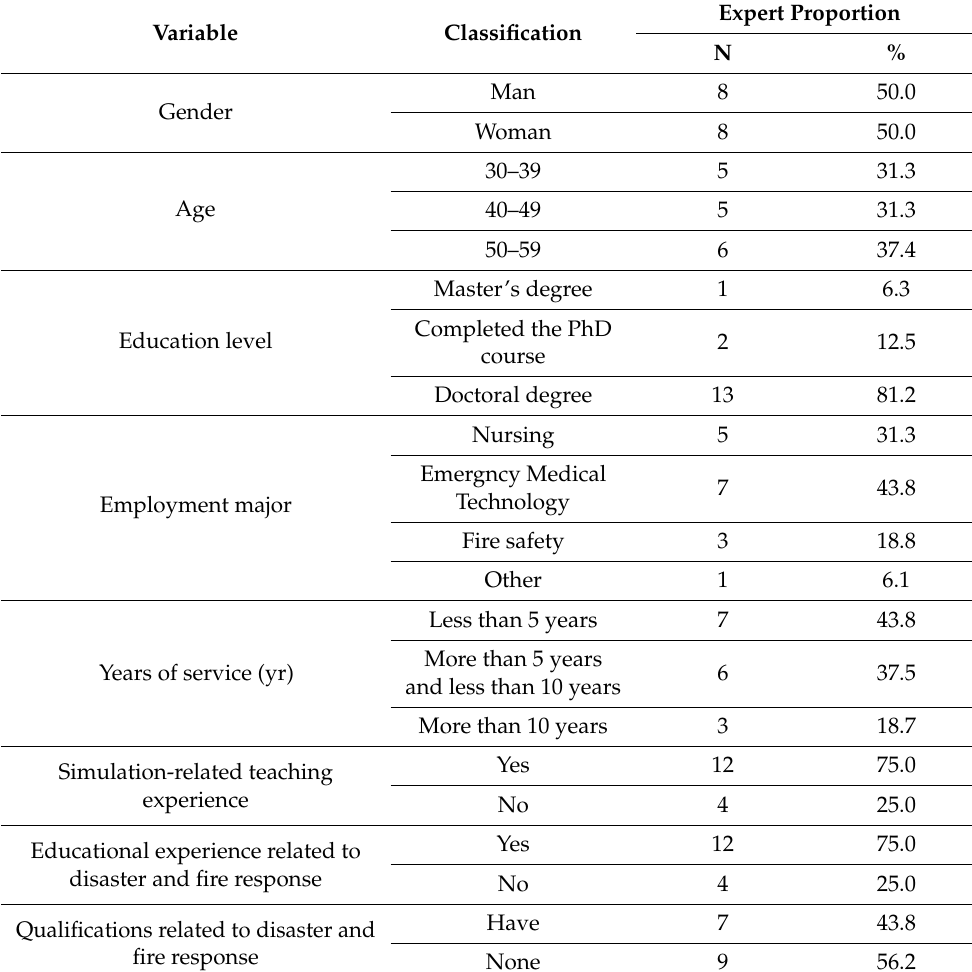
Table 3. General characteristics of